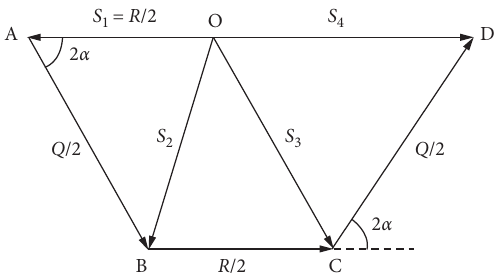
Figure 5: The stress superposition diagram of 3 stress